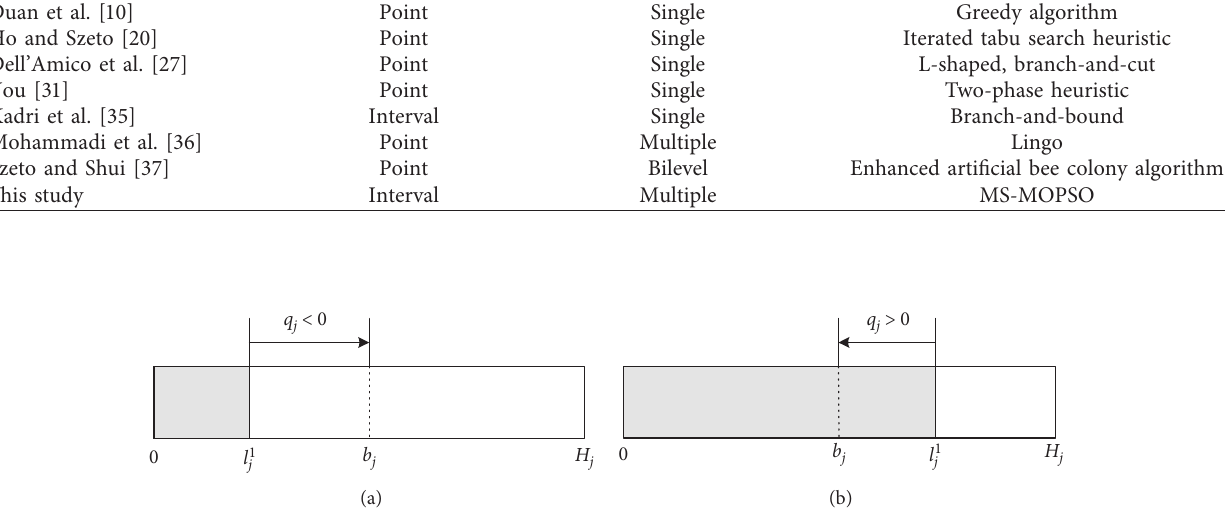
Figure 3: BSS station with balance point. The grey area represents the current level of occupation, while the white area represents the current vacant slots. H j is the maximum capacity of station j . (a) Delivery rebalance demand. (b) Pickup rebalance demand.